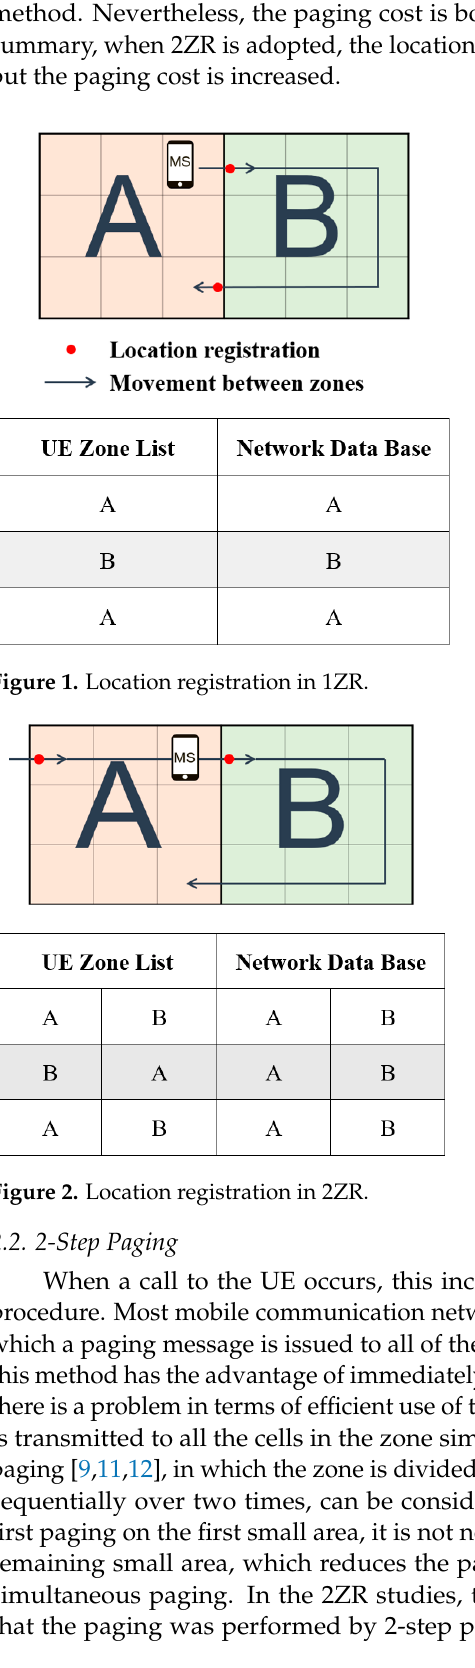
Figure 2. Location registration in 2ZR.